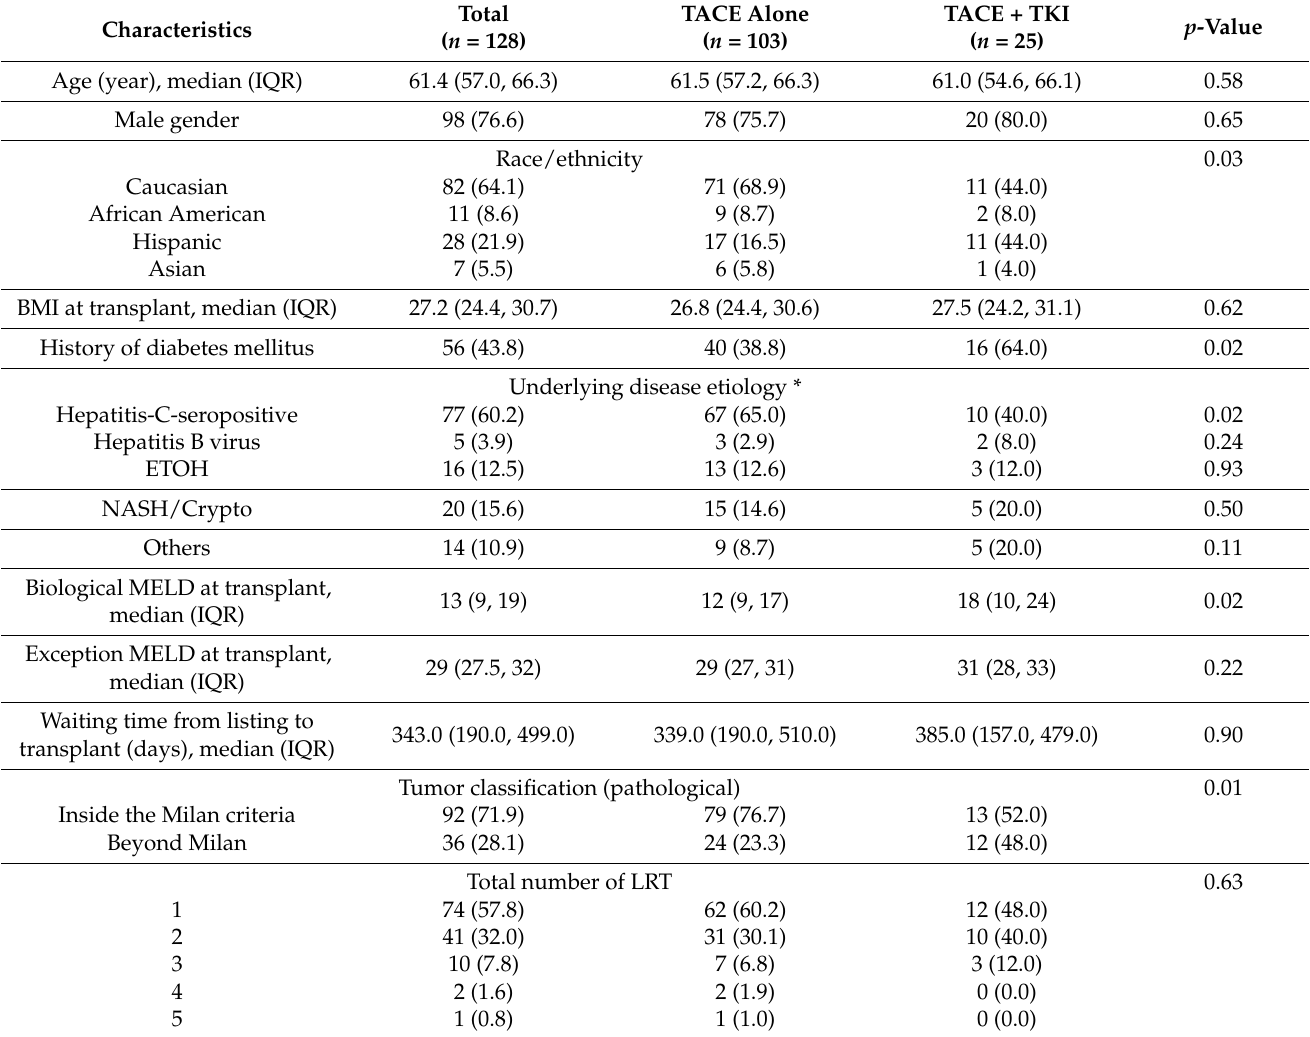
Table 1. Patient demographics were stratified by the TACE